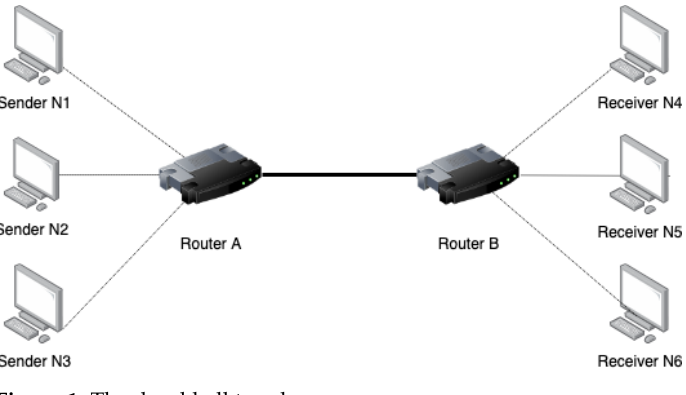
Figure 1. The dumbbell